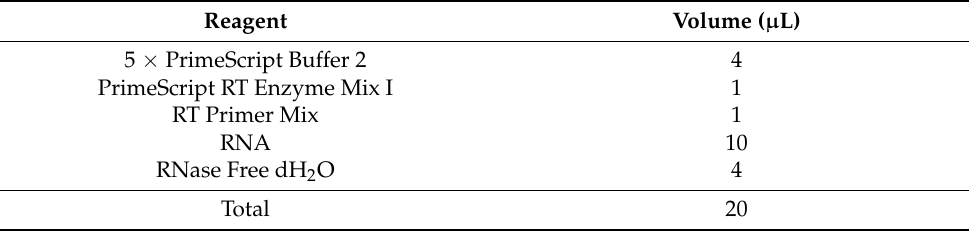
Table 5. Reverse transcription reaction system.